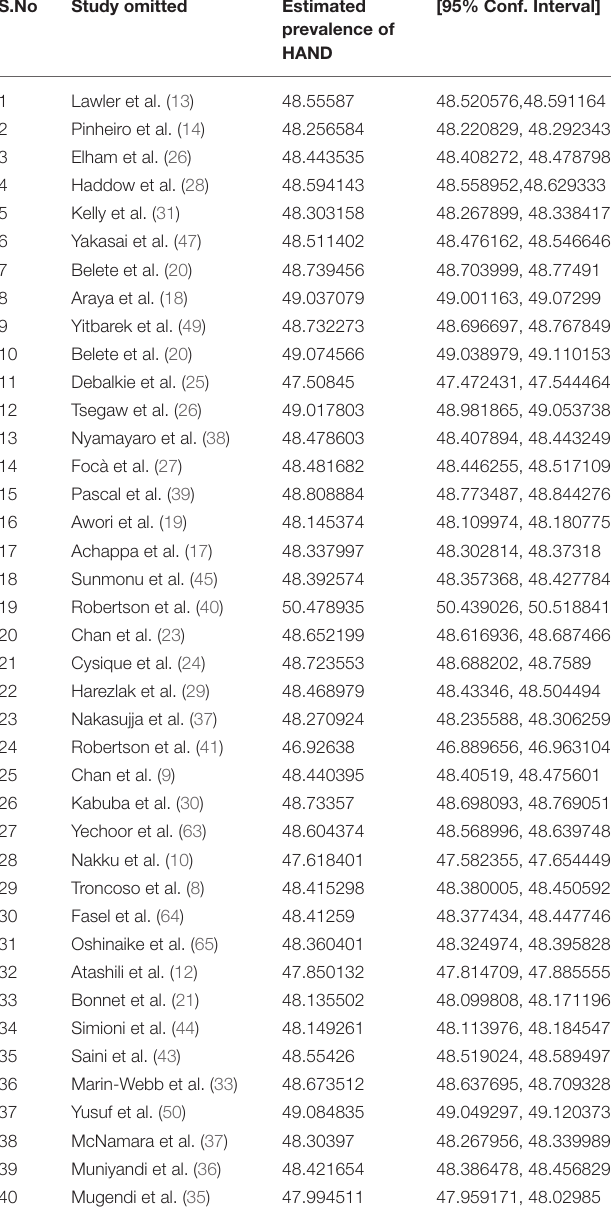
TABLE 2 | A sensitivity analysis of the prevalence of HIV associated neurocognitive disorders in HIV/AIDS patients when each indicated studies are omitted at a time with its 95% confidence